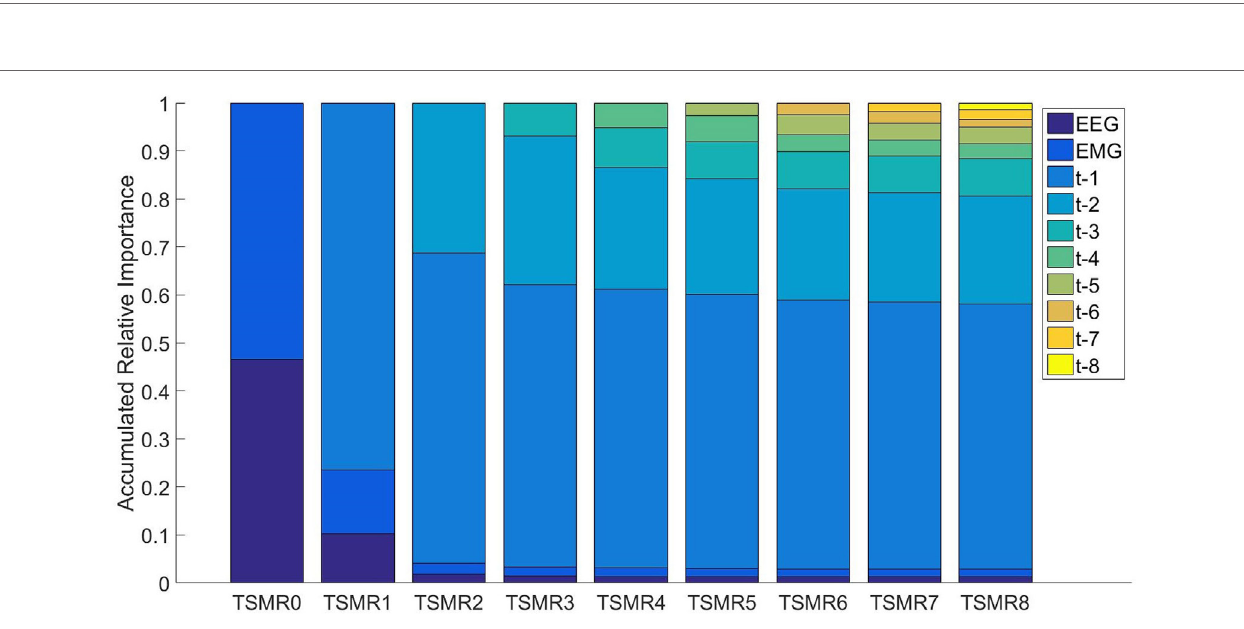
FigUre 6 | The accumulated relative importance for different configurations of TsMr N . In the case of TSMR 0 , only EEG (darker blue) and EMG (lighter blue) are present. In the rest of the configurations, the added bars correspond to the added time information. For example, in TSMR 1 , the bar in the top corresponds to the previous reconstructed point. In the case of TSMR 8 , there are eight bars corresponding to the previous reconstructed points plus the EEG and